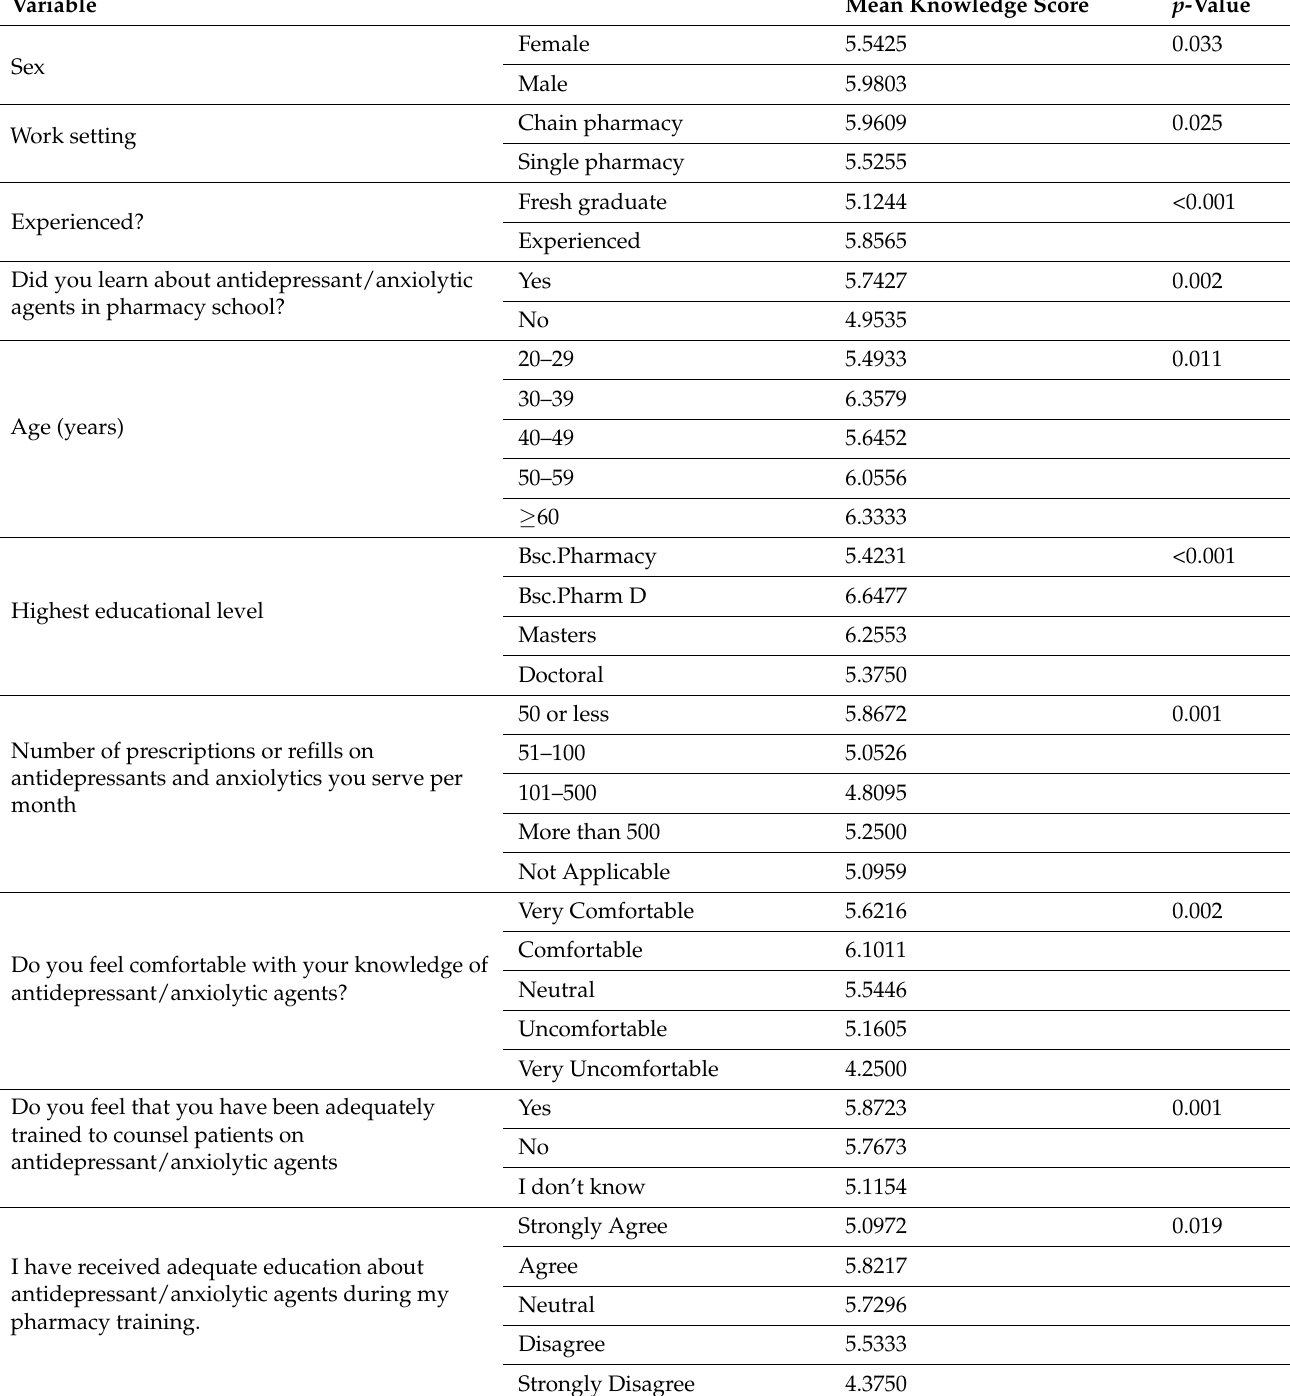
Table 4. Differences in the knowledge mean scores across the study